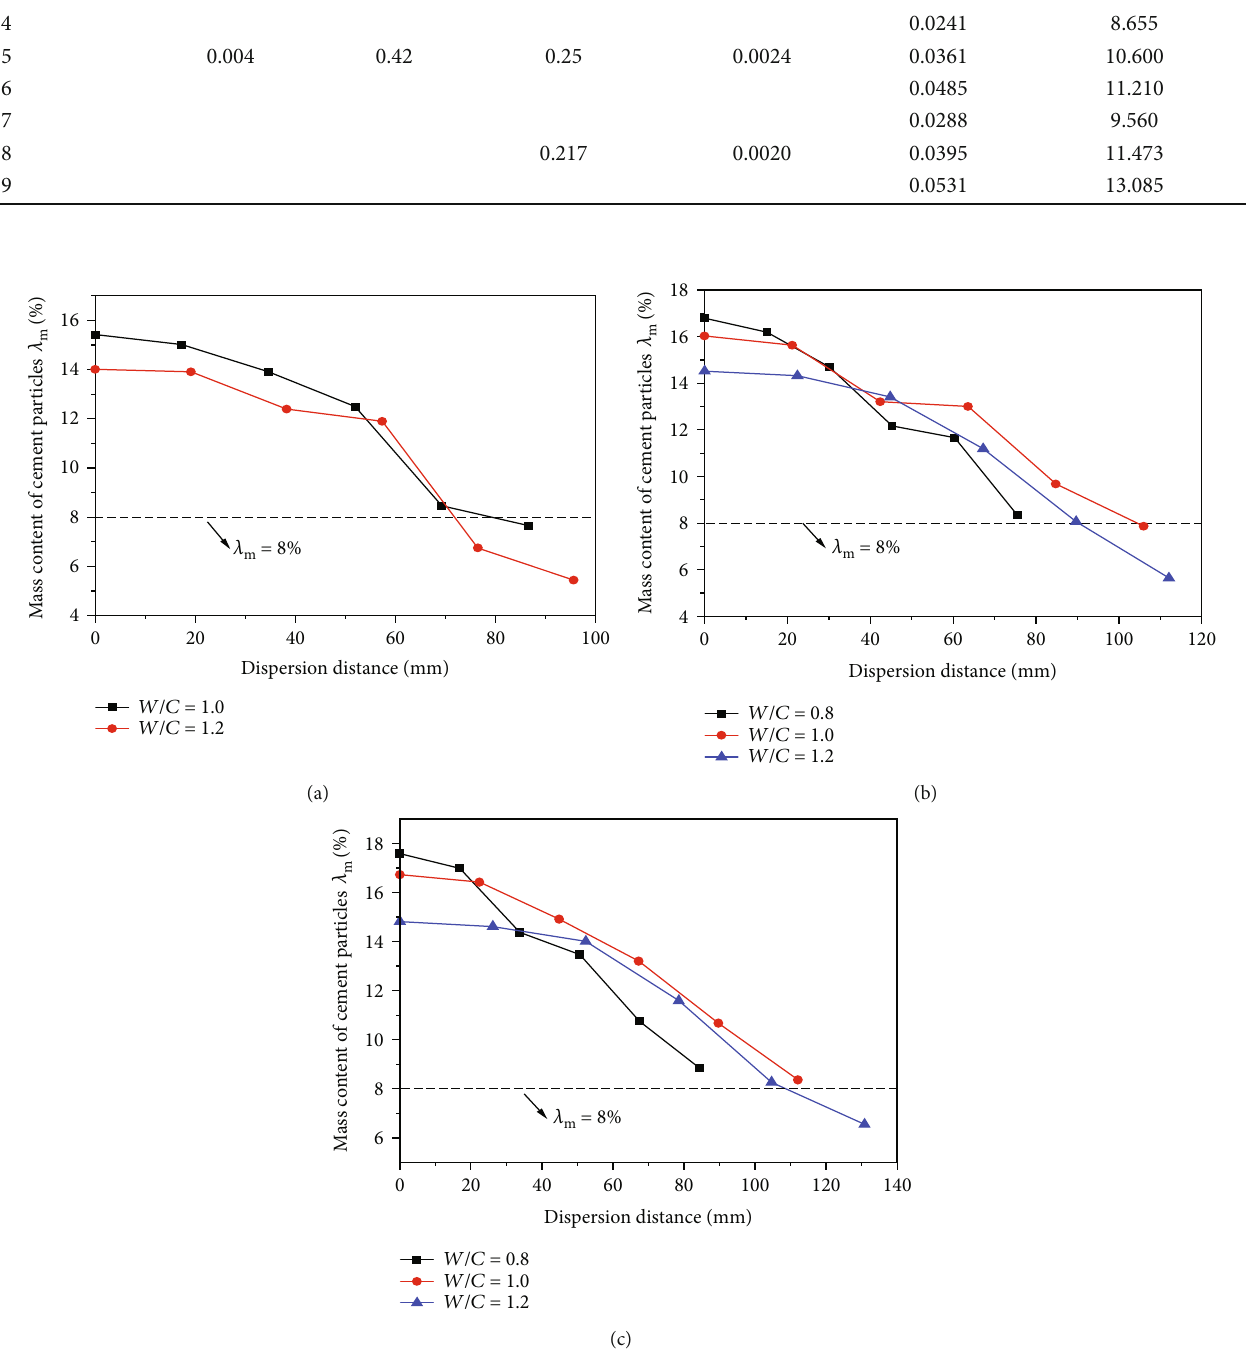
Figure 6: Distribution of cement content along the radius of grouted mass: (a) P = 180 kPa ; (b) P = 200 kPa ; (c) P = 220 kPa